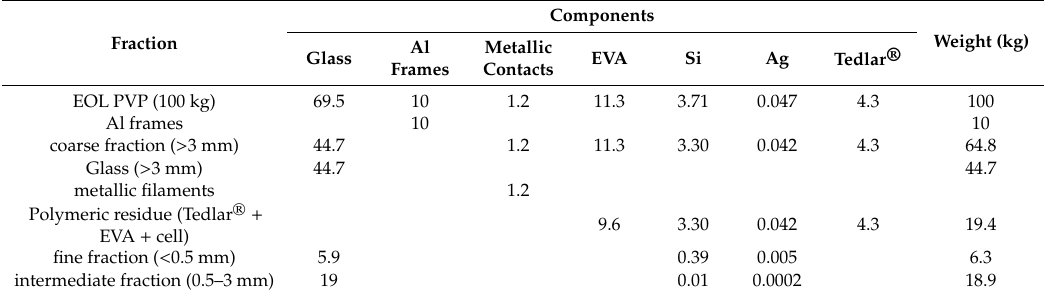
Table 1. Mass balance and fraction composition for the PhotoLife process. Table 2. Recycling rate, recovery rate, amount of wastes produced, and recoverable value according to mass balances for the PhotoLife process considering 100 kg EOL PVP as process input